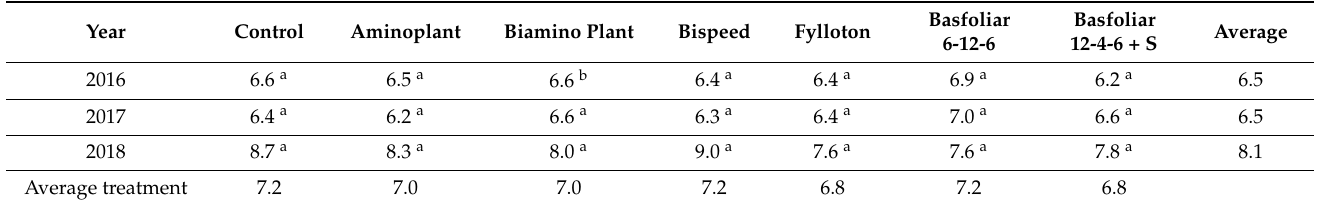
Table 2. The diameter of M.9 rootstock stoolings depending on the tested treatments (mm).